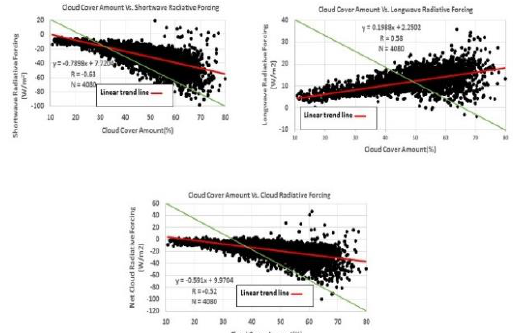
Figure 9. Scatter plots between monthly mean cloud cover amount (%) with SWCRF, LWCRF, NCRF (Wm - 2 ) from the CERES over the east box during June to